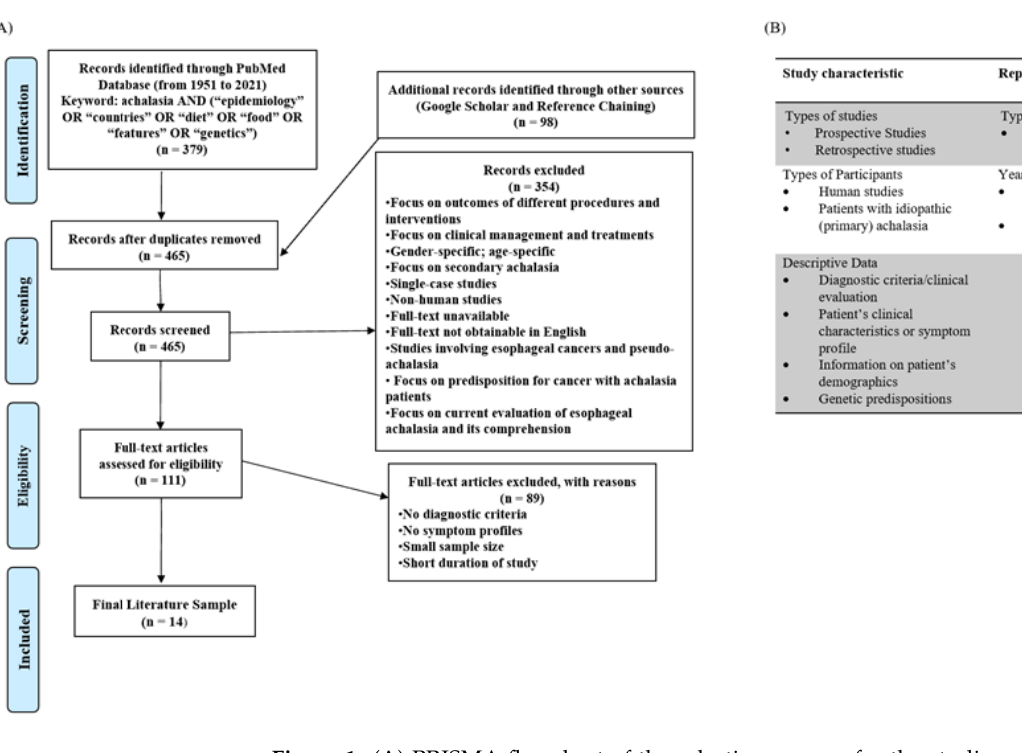
Figure 1. ( A ) PRISMA flowchart of the selection process for the studies evaluated in this review. ( B ) Table of eligibility criteria for selecting studies involving idiopathic achalasia and patients’ clinical symptoms.